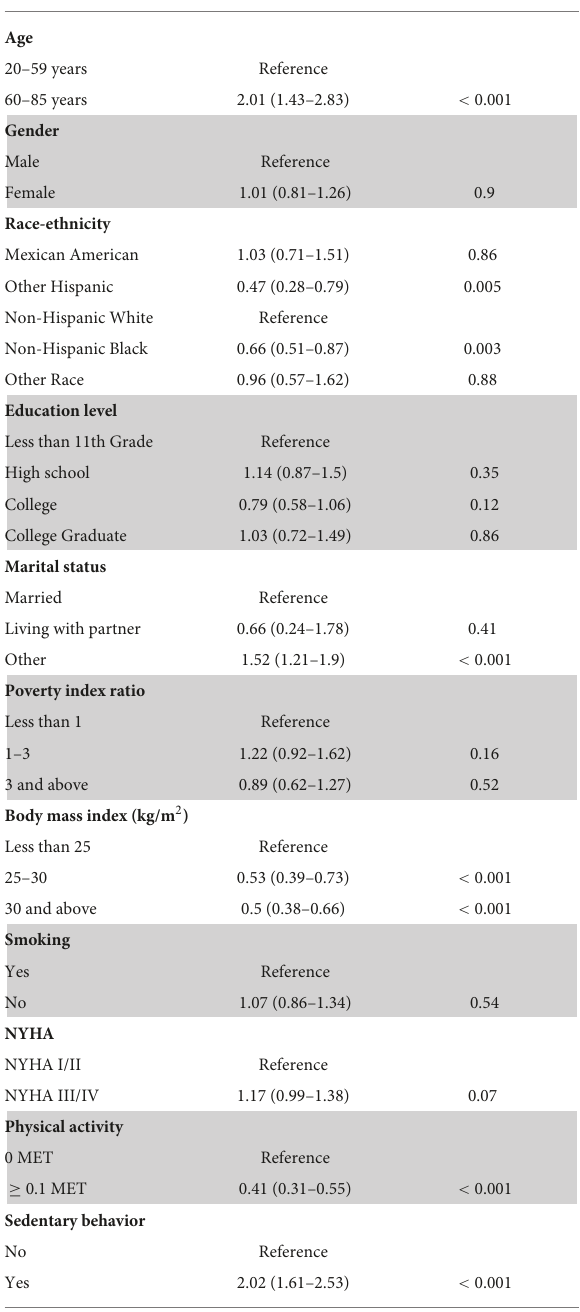
TABLE 2 Univariate cox regression factors associated with all caused death.